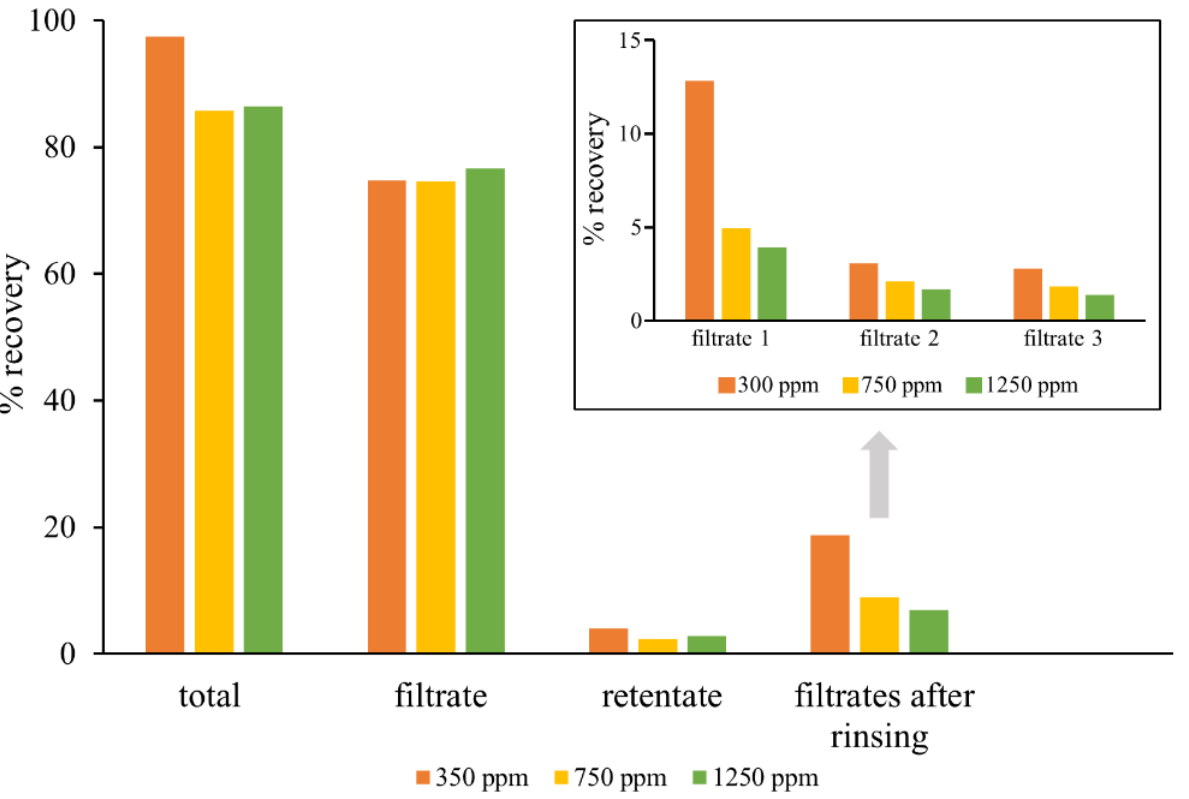
Figure 1. Monitoring of CA recovery in QC samples during diafiltration process by determination of its amount in filtrate, retentate, and filtrates that were obtained after three rinsing cycles with water. Therefore, precipitation of IgGs with ACN (with or without TFA), methanol, and ethanol was investigated. Addition of one volume of acetonitrile almost completely precip- itated IgGs, in contrast to methanol and ethanol, which appeared completely ineffective.